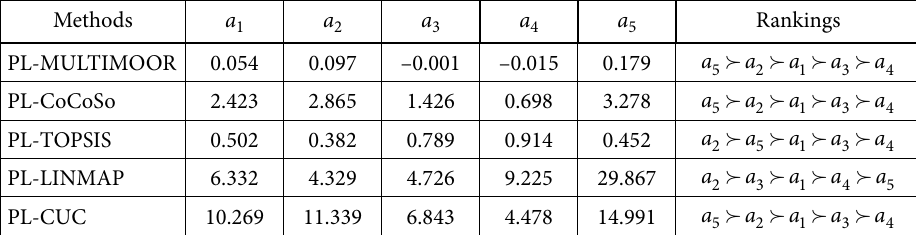
Table 4. The results derived by different PL-MCDM methods Methods a 1 a 2 a 3 a 4 a 5 Rankings PL-MULTIMOOR 0.054 0.097 –0.001 –0.015